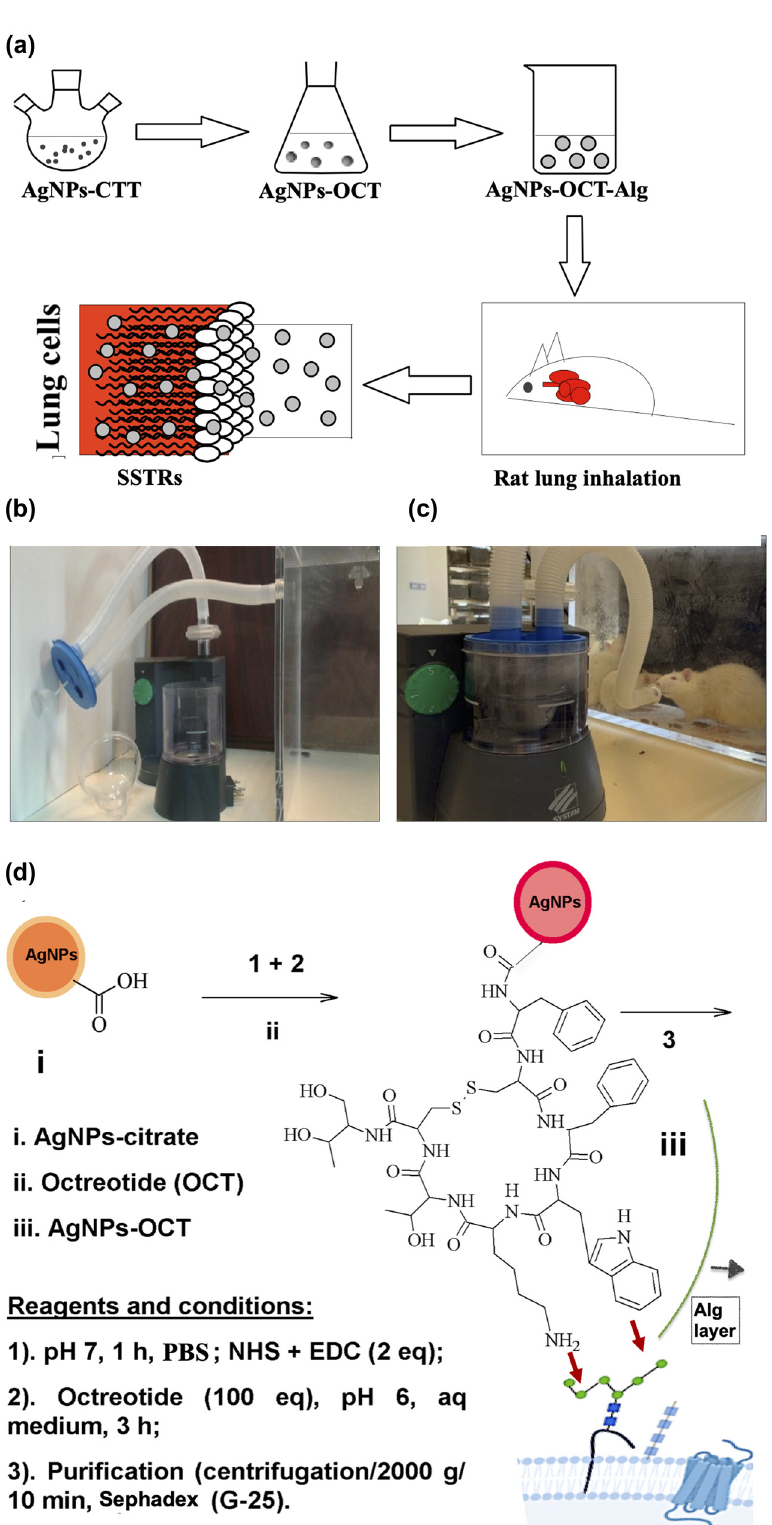
Figure 1: ( a ) Schematic diagram of AgNPs – OCT – Alg preparation and delivery to lung cells. ( b and c ) Nebulization of AgNPs – OCT – Alg among rats. ( d ) Schematic diagram of AgNPs – OCT synthesis; the AgNPs – OCT formed were coated with alginate for delivery to the lung cells and the proposed manner in which OCT fi ts into the SSTRs by interactions between lysine and